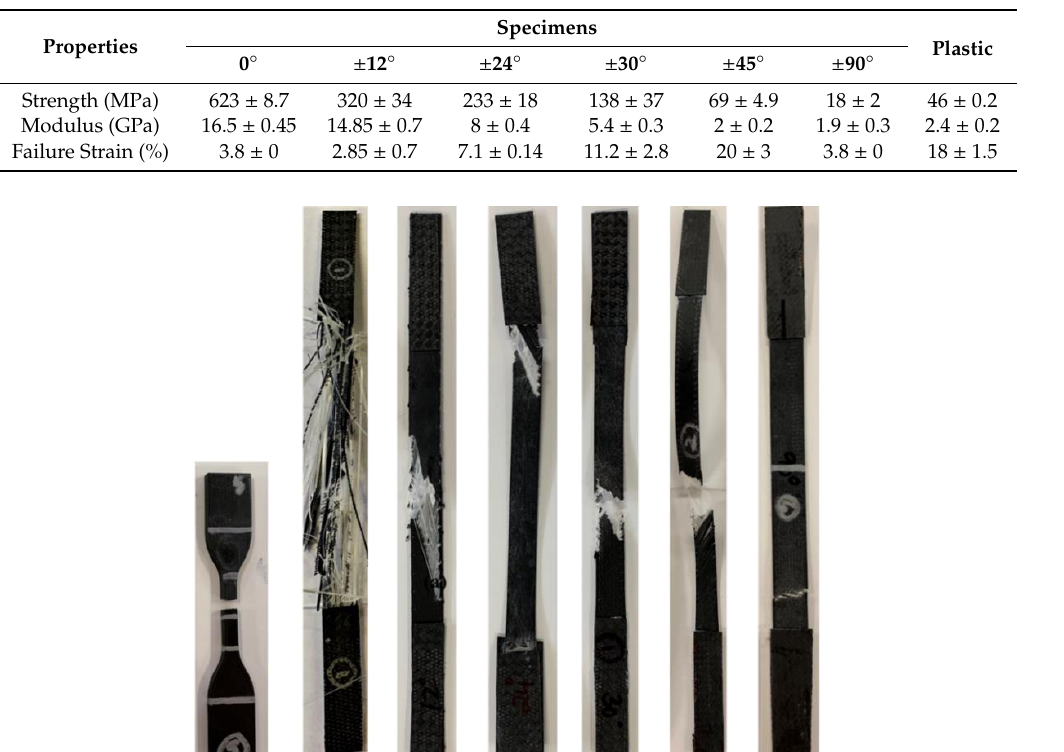
Table 3. Tensile properties of single-angled 3D-printed GFRP composite specimens (Set 1) and 3D-printed thermoplastic specimens.